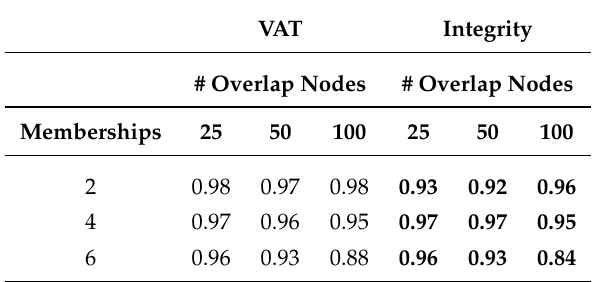
Table 10. Normalized mutual information for scale free LFR benchmark networks with overlap. Bold text indicates one-step clustering. VAT Integrity # Overlap Nodes # Overlap